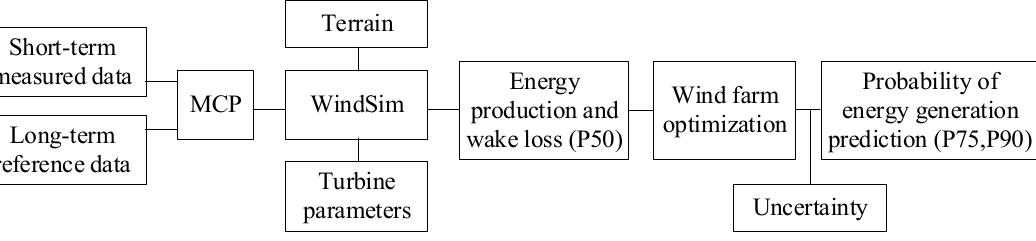
Fig ure 1. Flowchart of this study. Figure 1. Flowchart of this